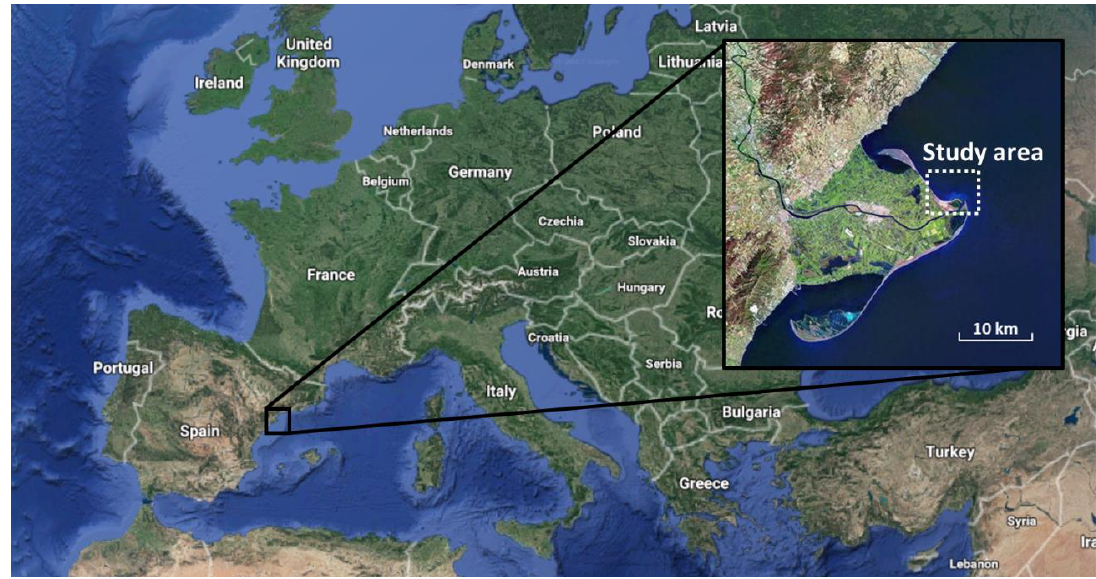
Figure 1. Location of the study area. Modified from Google Earth and Institut Cartogràfic i Geològic de Catalunya (ICGC) (http://www.icc.cat/vissir3/).